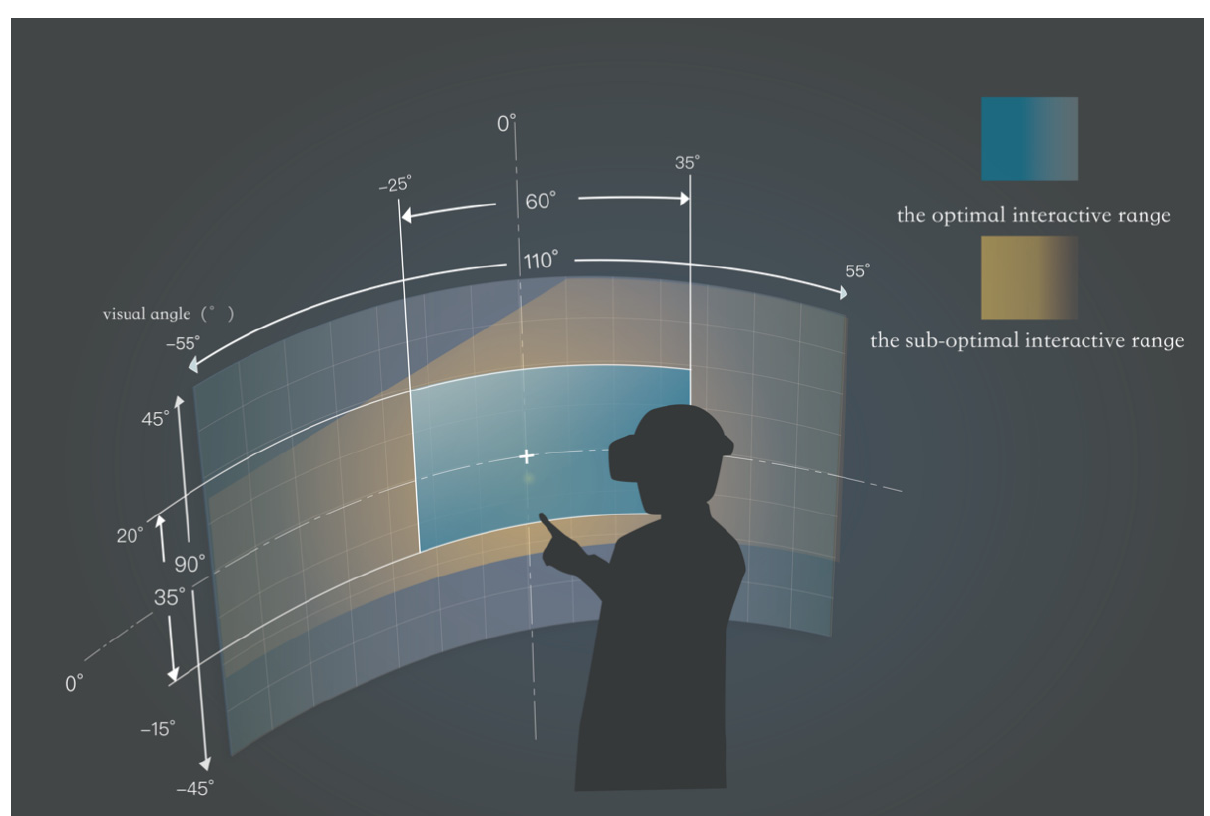
Figure 11. Suggested areas for the bare-hand interaction in the VE.